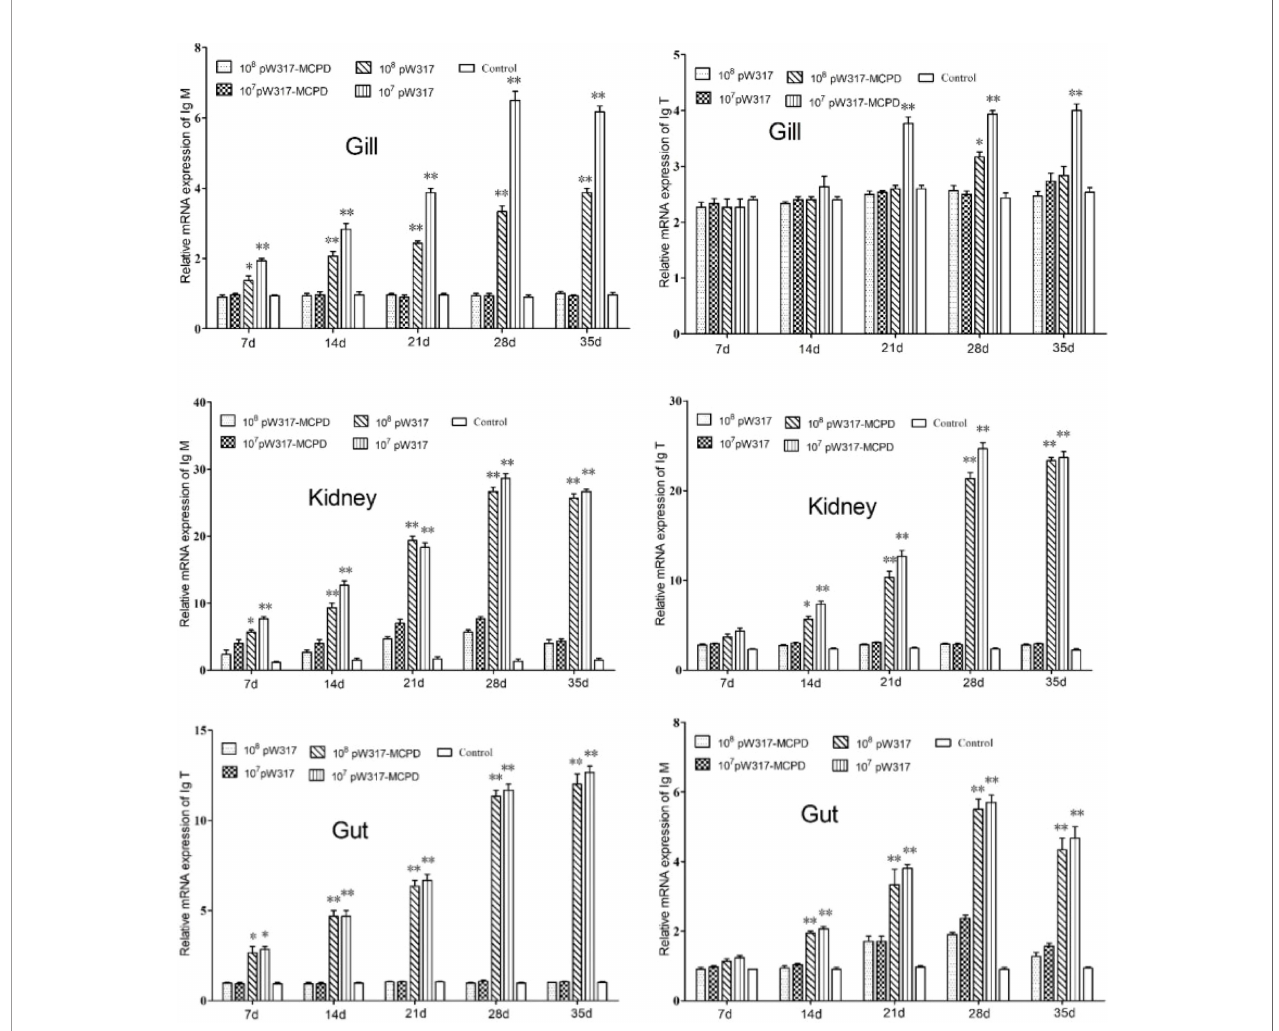
FIGURE 3 | The expression level of IgM and IgT in different tissues after immunization. 10 7 pW317: 10 7 CFU/g GS115-pW317; 10 8 pW317: 10 8 CFU/g GS115- pW317; 10 7 pW317-MCPD: 10 7 CFU/g GS115-pW317-MCPD; 10 8 pW317-MCPD: 10 8 CFU/g GS115-pW317-MCPD. **P < 0.01; *P <